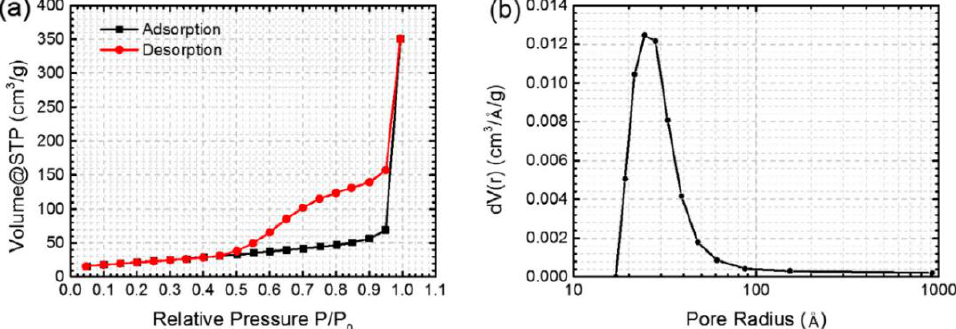
Figure 19. Evaluation of CeMo nanocontainers using BET: ( a ) adsorption and desorption isotherms and ( b ) pore size distribution.